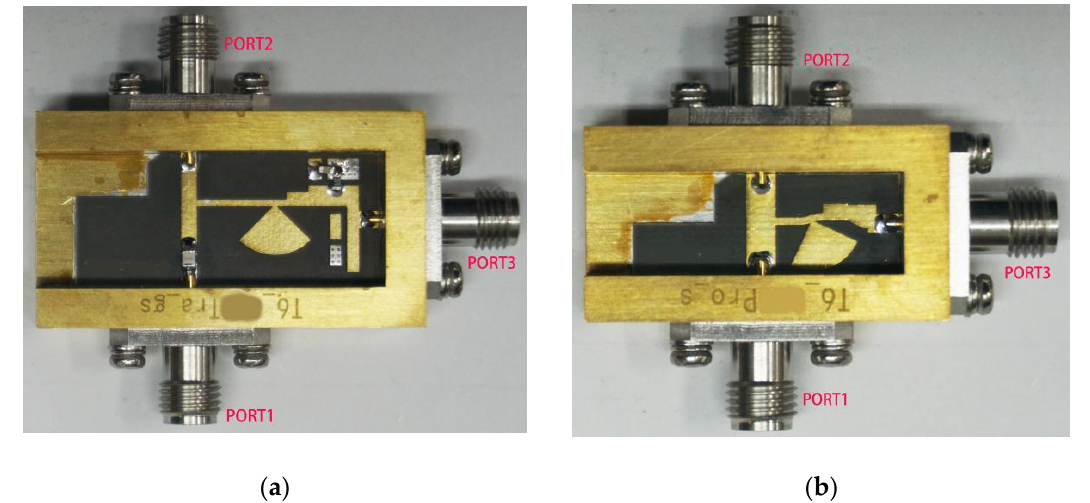
Figure 11. The fabricated microstrip circuit welded on the copper base. ( a ) The traditional bias circuit. ( b ) The proposed bias circuit.